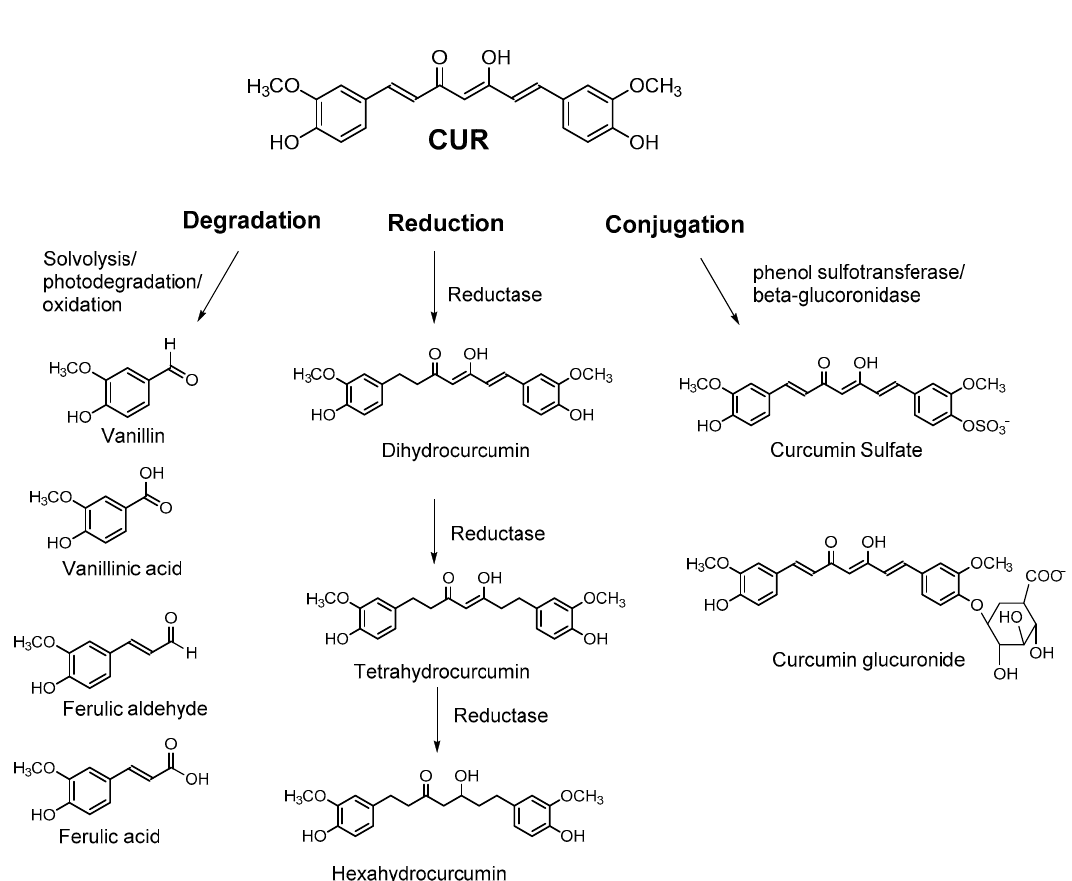
Figure 3. Curcumin degradation and metabolism products.